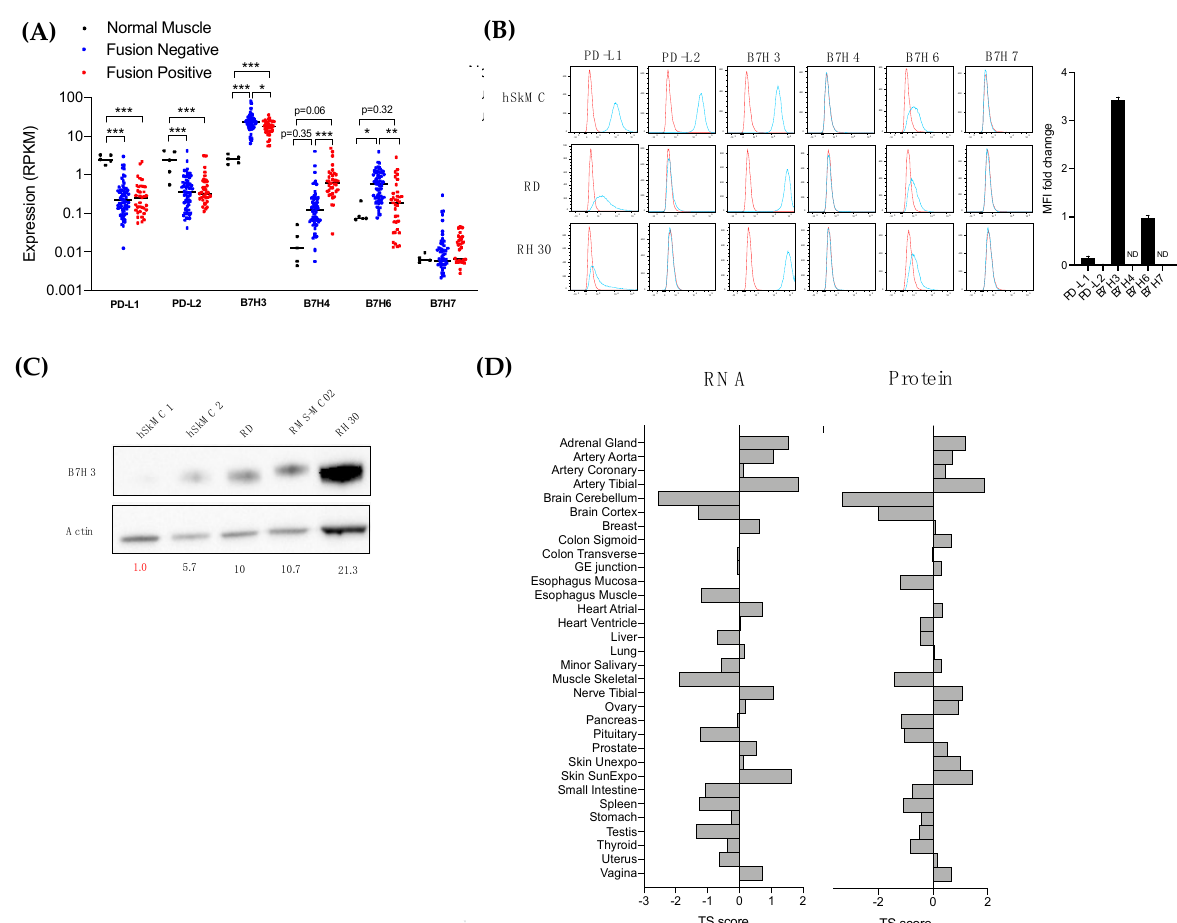
Figure 3. Expression of the immune checkpoint molecule B7-H3 in RMS and normal tissue. ( A ) Normalized expression (RPKM) of B7 molecules from RNA sequencing of normal muscle (N = 5), fusion negative (N = 66), and fusion positive (N = 35) RMS samples. Each data point represents an individual sample. The median is noted by a horizontal bar and significance denoted by asterisks (*** p < 0.001; ** p < 0.01; * p < 0.05; n.s., not significant, Student’s t -test). ( B ) Histograms of flow cytometric analysis of B7 molecule expression in RMS and normal muscle cell lines. Bar graph shows mean fluorescence intensity (MFI) fold change in RMS cell lines compared to normal muscle. ND indicates “not detectable” expression ( C ) Western blot of B7H3 expression in 5 different cell lines. Band intensity for B7-H3 normalized on actin is indicated for each cell line. ( D ) Tissue Specific (TS) score of protein and RNA expression of B7H3 in each normal tissue (obtained from Jiang et al. [15].